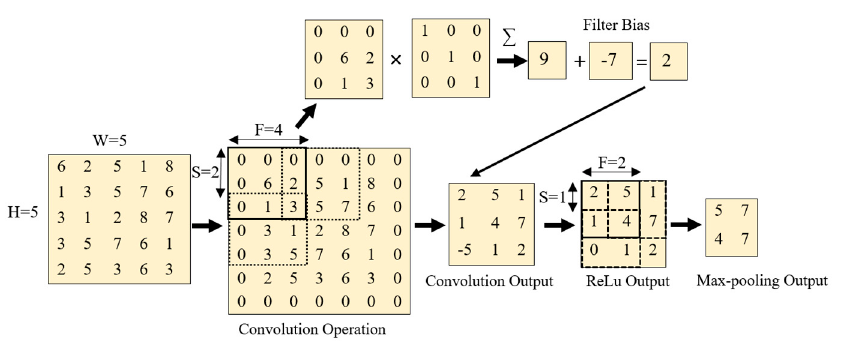
Figure 3. Mathematical operations in convolutional, rectified linear unit (ReLu), and max-pooling